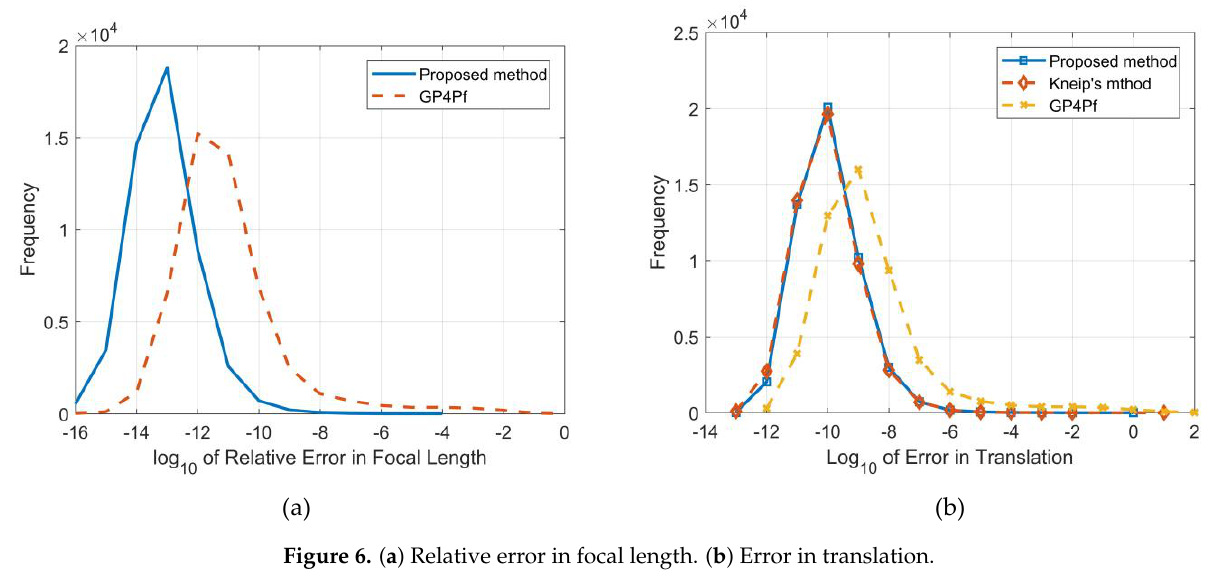
Figure 6. ( a ) Relative error in focal length. ( b ) Error in